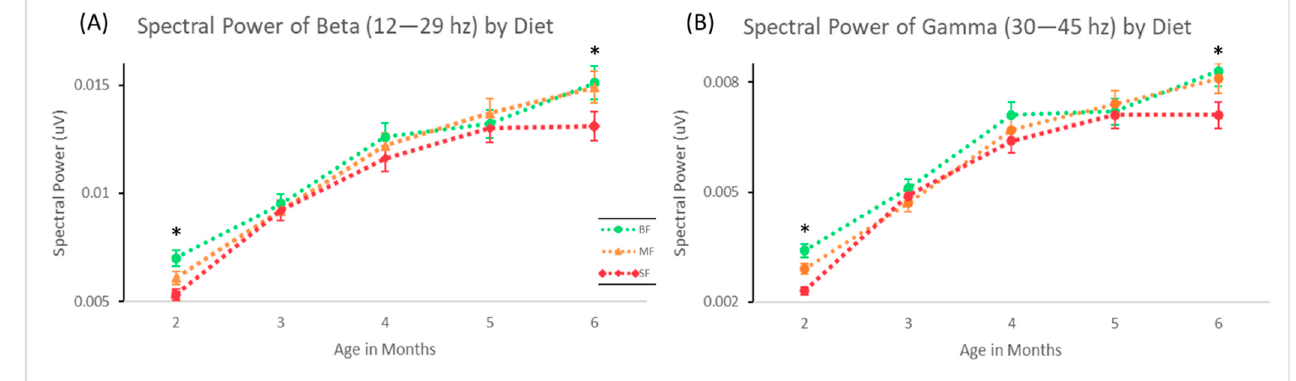
Figure 1. Dietary and age-associated changes in the averaged global spectral power in beta (15–29 Hz, ( A )) and gamma (30–45 Hz, ( B )) bands. * indicates a p < 0.05 for the BF vs. SF group in both ( A ) and ( B